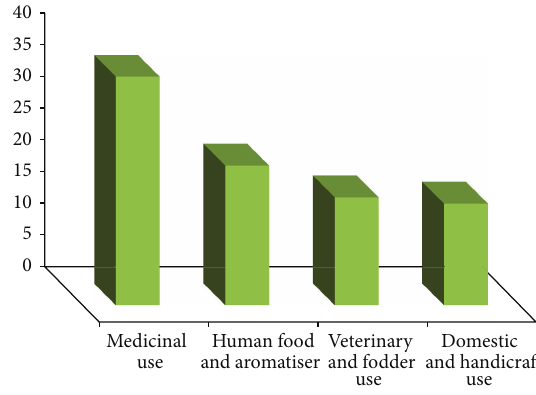
Figure 3: Four main categories of plants use in study.